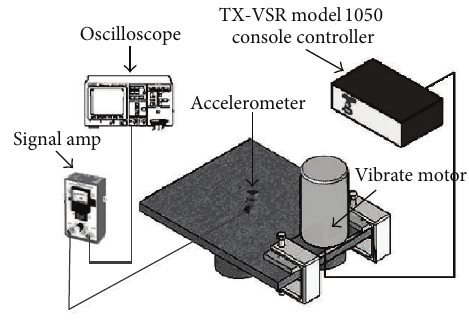
Figure 2: The oscilloscope examination system of the